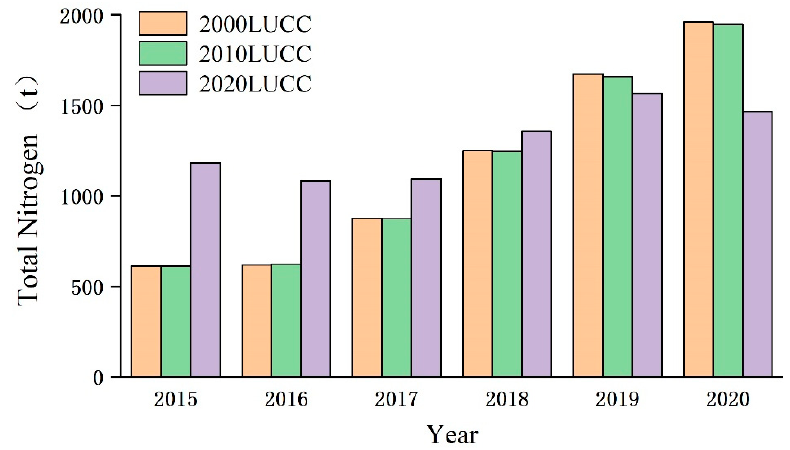
Figure 16. Annual load of total nitrogen under three land use phases.